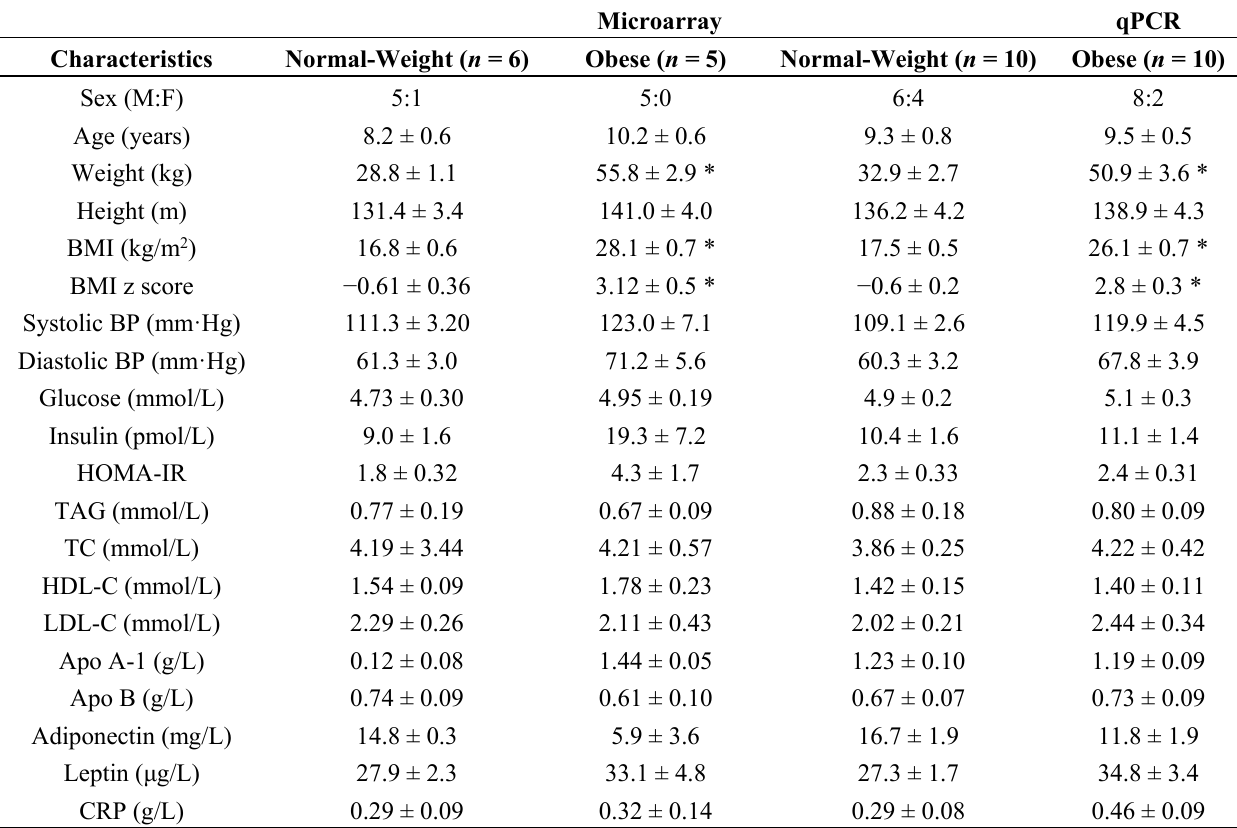
Table 1. Clinical and biochemical characteristics of the prepubertal